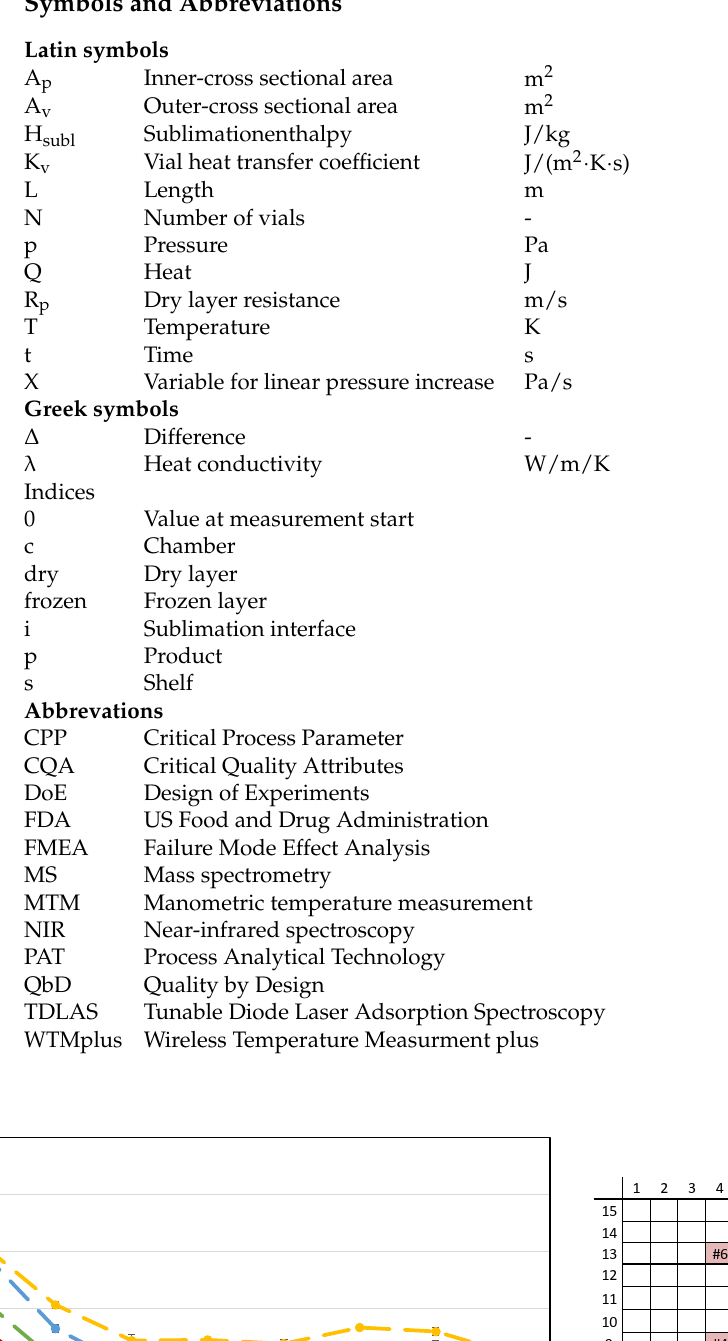
Figure A2. Forwarding condition compared to comparative pressure measurement on- and midset.